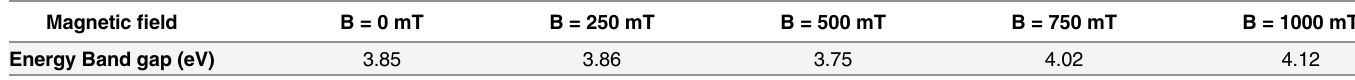
Table 1. Comparison of the E g values of CG 100 determined versus several strengths of magnetic field.